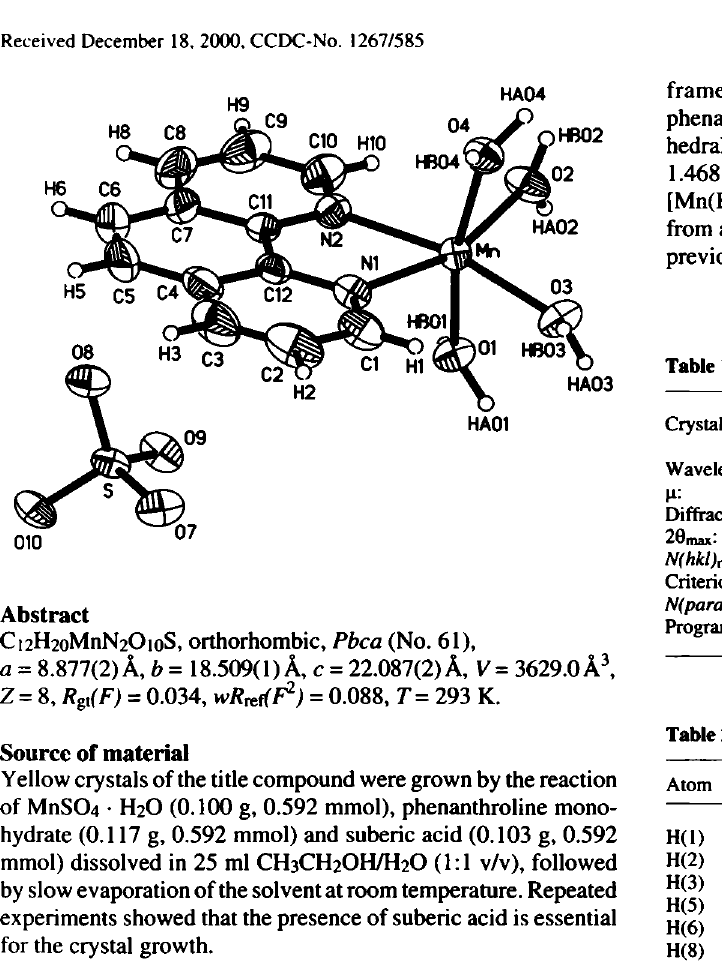
Table 1. Data collection and handling.